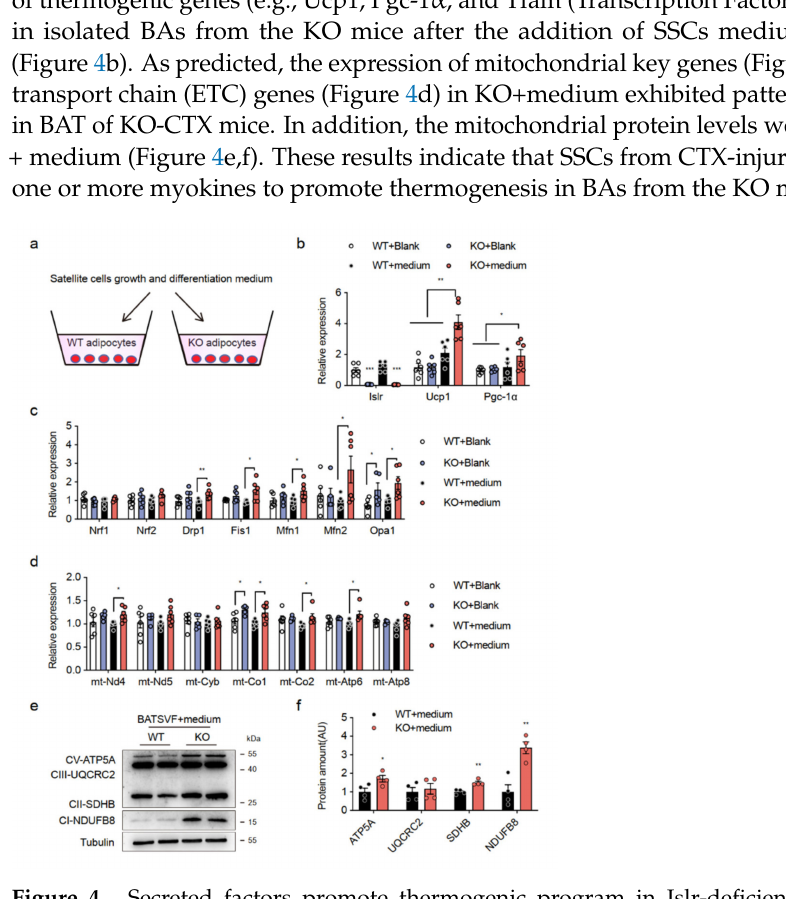
Figure 4. Secreted factors promote thermogenic program in Islr-deficient brown adipocytes; ( a ) schematic illustration of the cell culture process; ( b ) gene expression (thermogenesis genes) in WT and KO differentiation BATSVF treated with blank or skeletal satellite cell growth and dif- ferentiation medium (n = 6); ( c , d ) gene expression (mitochondrial genes and ETC genes) in WT and KO differentiation BATSVF treated with blank or skeletal satellite cell growth and differenti- ation medium (n = 5–6); ( e ) Western blot analysis of OXPHOS proteins in treated differentiation BATSVF; ( f ) Protein levels were quantified using Image J (n = 4). Error bars represent SEMs, * p <